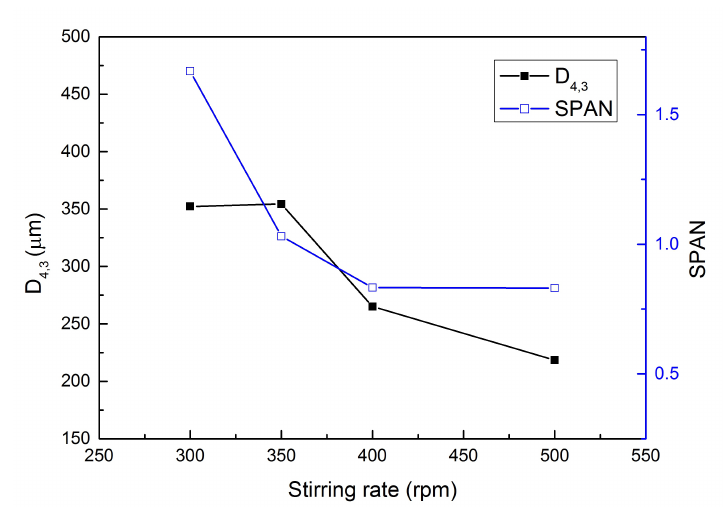
Figure 8. Size distribution of PF microcapsules prepared at various stirring rates (300, 350, 400 and 500